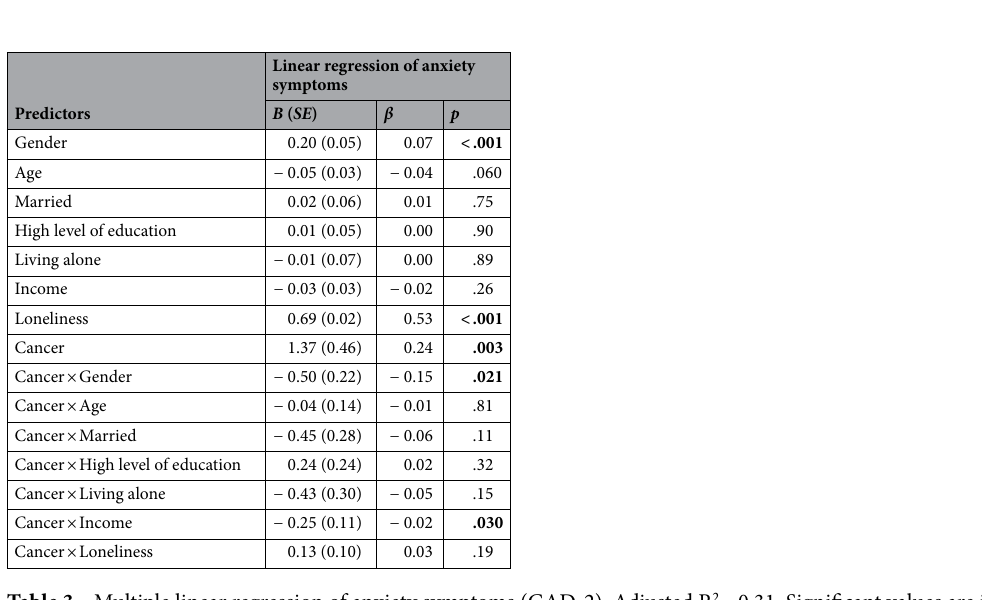
Table 3. Multiple linear regression of anxiety symptoms (GAD-2). Adjusted R 2 = 0.31. Significant values are in